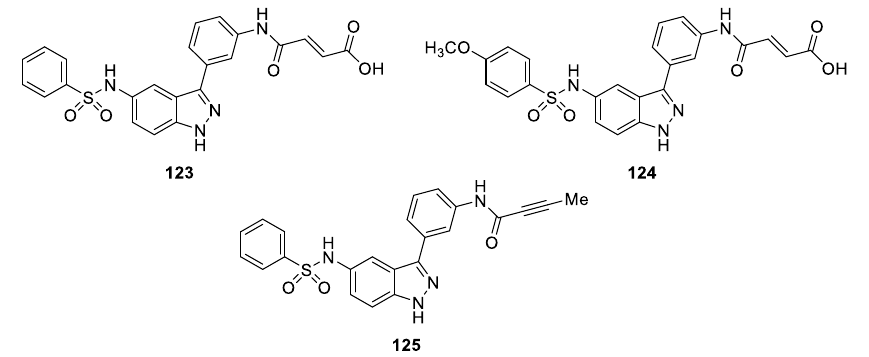
Figure 29. Chemical structures of 1 H -indazole derivatives 123 – 125 .